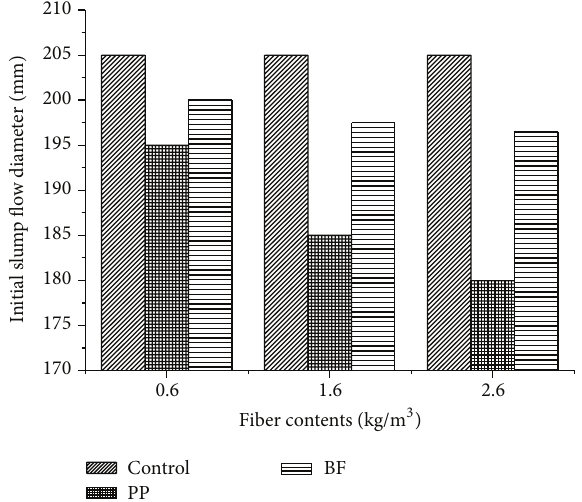
Figure 2: The effect of the contents of PP fiber and BF on the initial slump flow of the